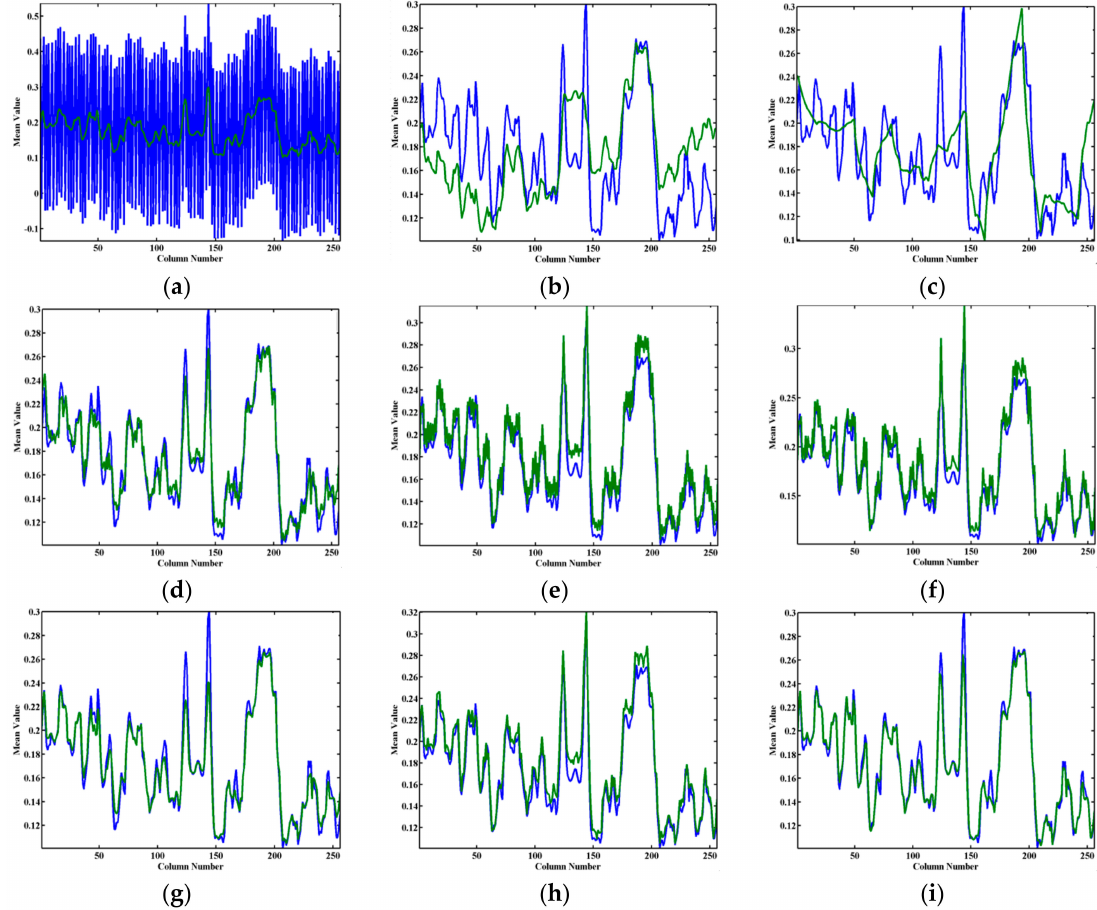
Figure 7. ( a ) Degraded with periodic stripes (case I = 60, r = 0.8), ( b ) UTV, ( c ) WFAF, ( d ) SGE, ( e ) ASSTV, ( f ) LRMID, ( g ) DL0S, ( h ) LRTD, and ( i )